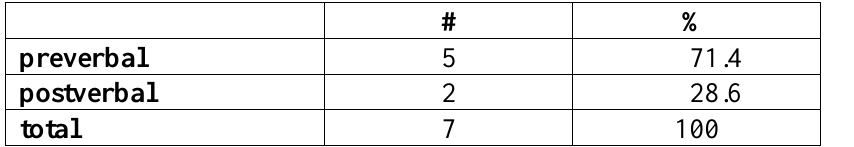
Table (6): Positioning of tú in direct non-cleft non-argumental wh -interrogatives